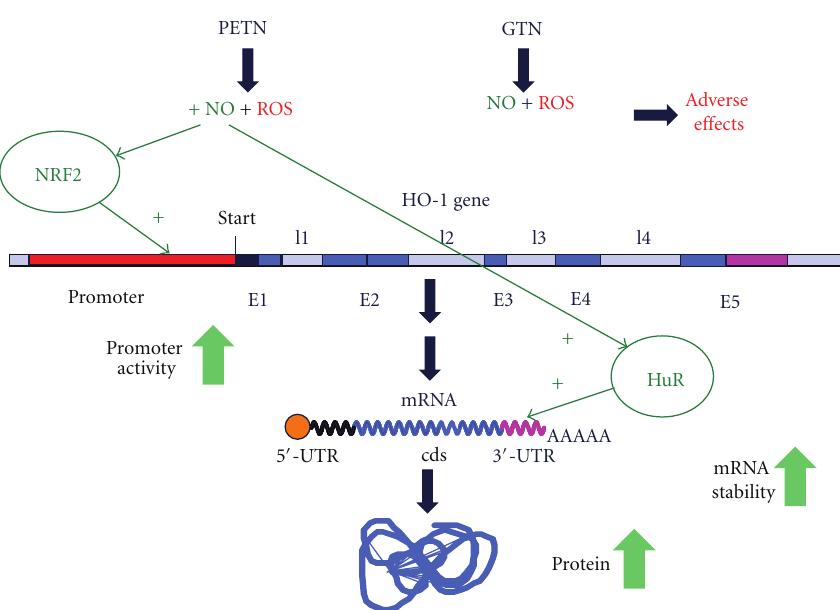
Figure 9: Molecular mechanisms of PETN-mediated enhancement of HO-1 expression. The high amounts of bioactive NO generated from PETN (but not GTN) activate the transcription factor NRF2 and thereby enhance the HO-1 promoter activity. In addition, the interaction of the stabilizing RNA binding protein HuR with the 3 (cid:3) -UTR of the HO-1 mRNA is enhanced. Both e ff ects result in an enhancement of HO-1 expression (E: exon, I: